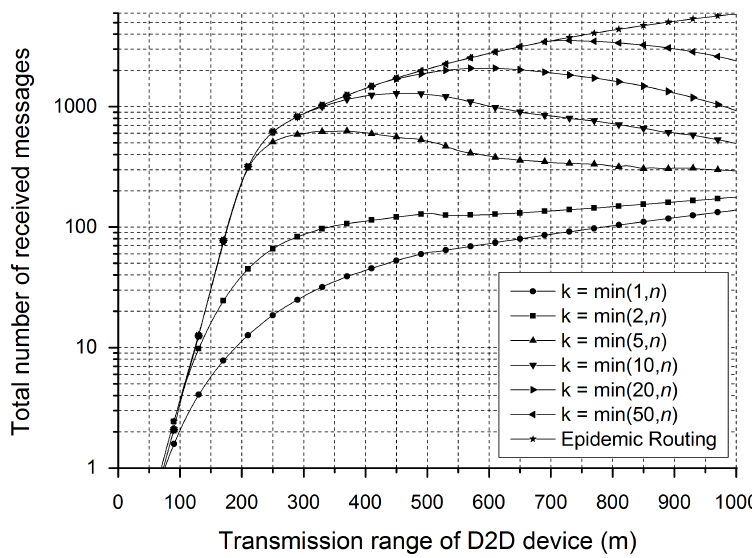
Figure 3. Total number of received messages vs. ¯ R when N = 100.